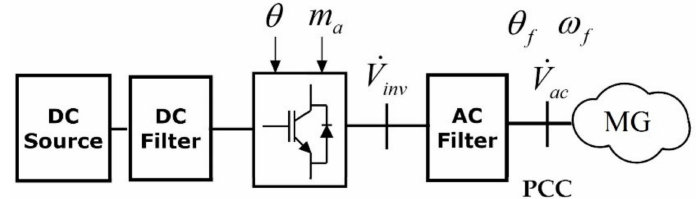
Figure 4. General layout of an inverter-based DG